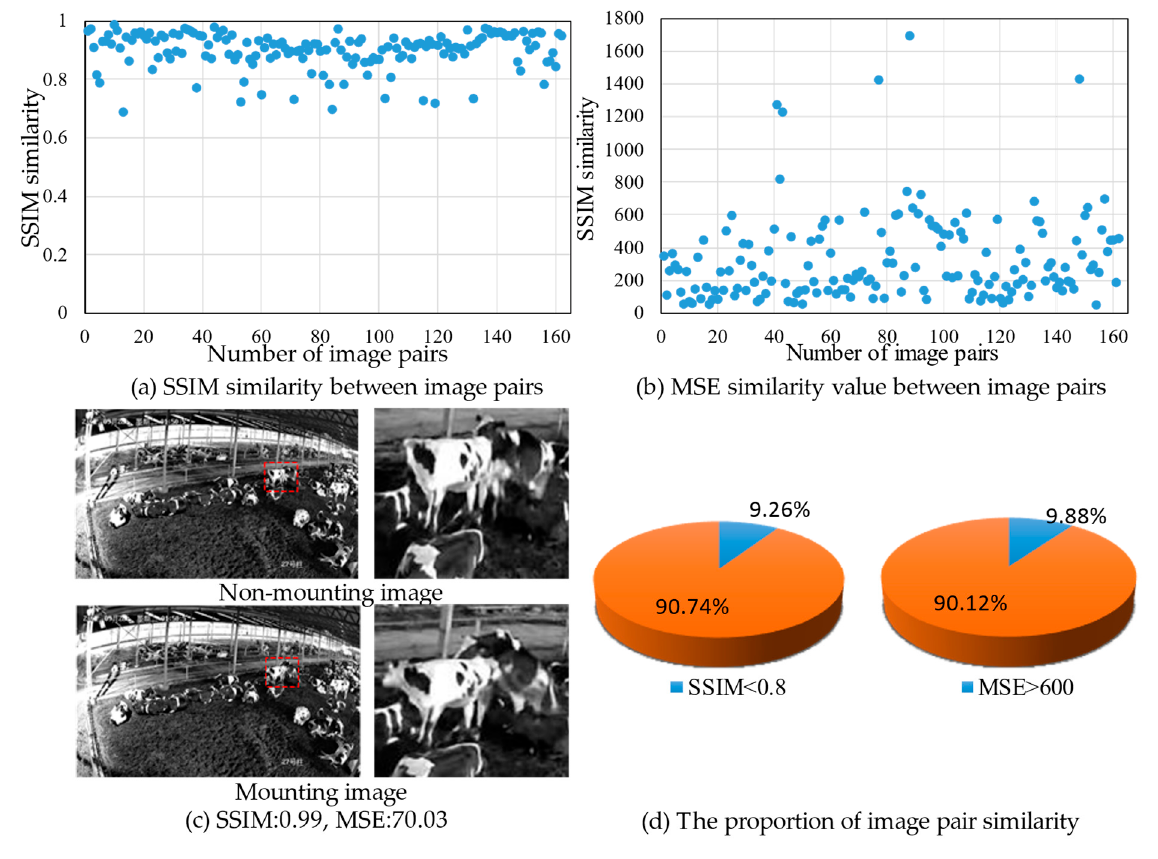
Figure 3. Similarity calculation results between image pairs.